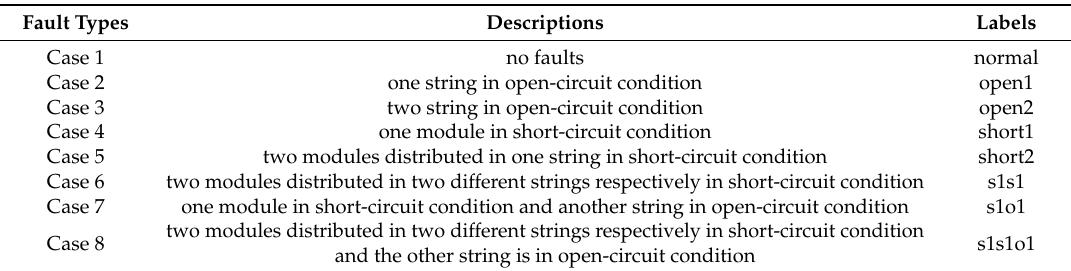
Table 2. Eight fault categories description.